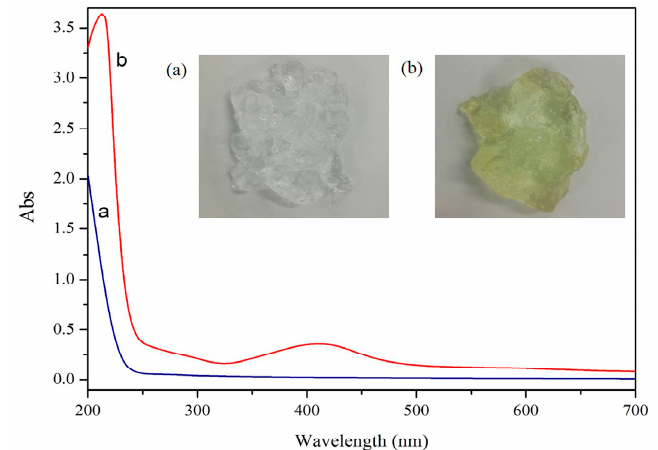
Figure 5. UV-Vis spectra of ( a ) CMC-g-PAA and ( b ) CMC-g-PAA/Ag.